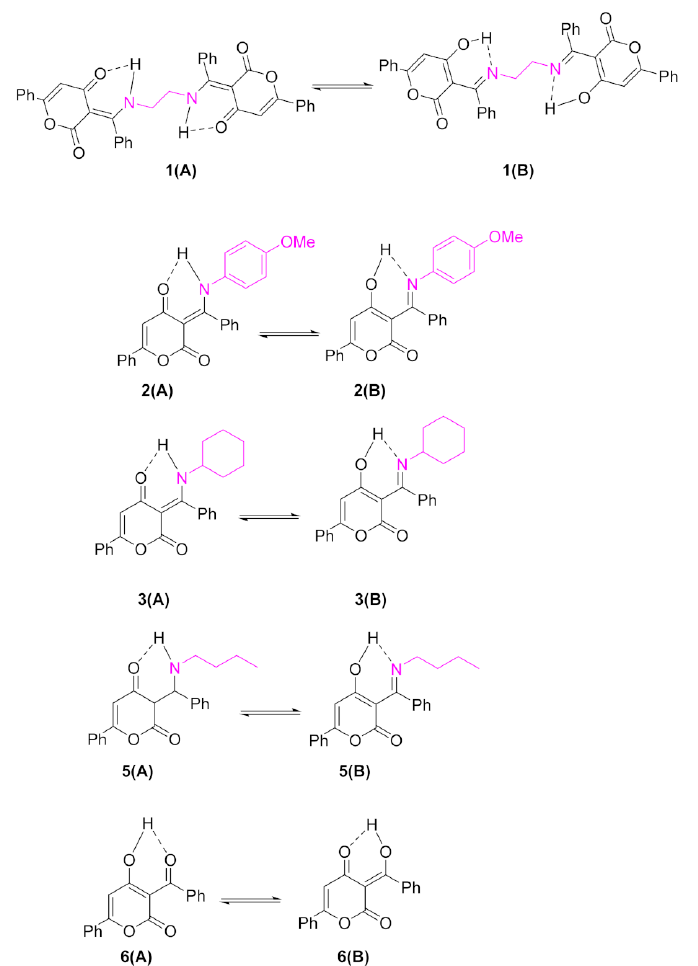
Figure 17. The suggested isomers of the studied